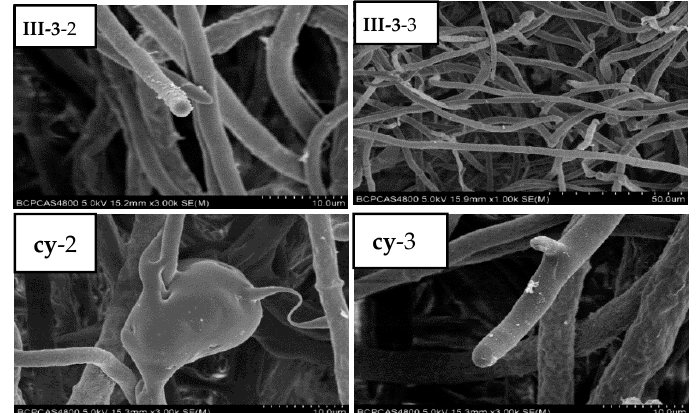
Figure 8. Effect of compound III-3 treatment on mycelial morphology of B. cinerea . CK: The blank control; III-3 -1: Compound III-3 treatment for 3 days at 0.78 μ g/mL; III-3 -2: Compound III-3 treatment for 3 days at 3.125 μ g/mL; III-3-3: Compound III-3 treatment for 3 days at 12.5 μ g/mL; cy-1: Cyprodinil treatment for 3 days at 0.78 μ g/mL; cy-2: Cyprodinil treatment for 3 days at 3.125 μ g/mL; cy-3: Cyprodinil treatment for 3 days at 12.5 μ g/mL.